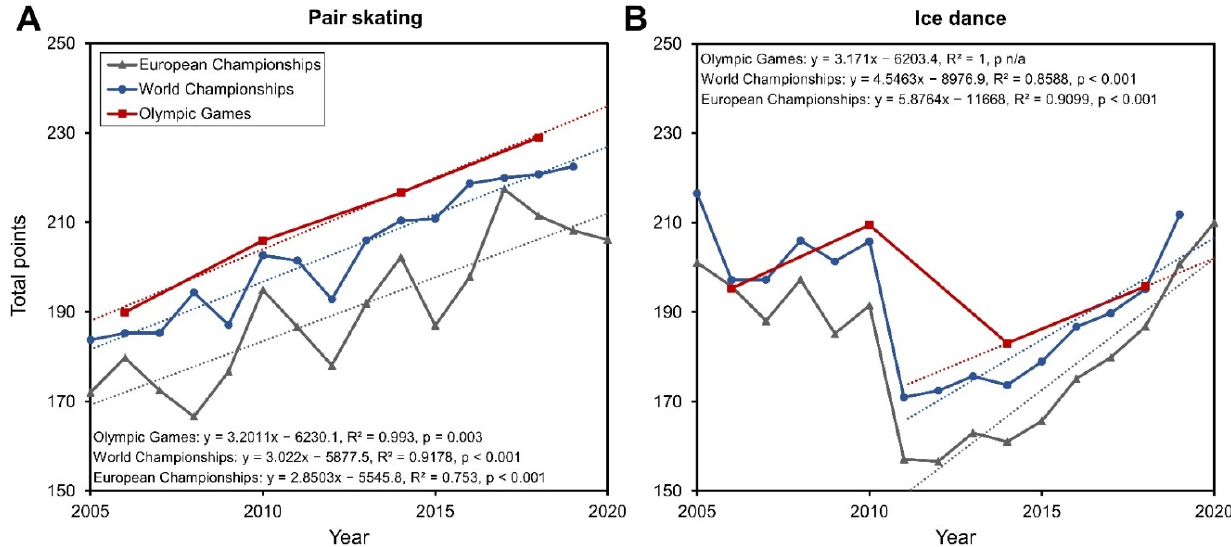
Figure 1. Trends of the average total points of the best five pairs in pair skating ( A ) and ice dance ( B ) at the European and World Figure Skating Championships, and the Olympic Games since 2005. Linear regression analysis was performed to show trends over time in pair skating (2005–2020) and ice dance (2011–2020). Regression functions, coefficients of determination (R 2 ) and p values (ANOVA, dependent variable: average total points of the best five pairs, independent variable: year) are shown for each group. In ice dance, a drop in total points followed a change in regulations in 2010. Note the performance peaks in pair skating at the European Championships in years with Winter Olympics. Table 1. Regression parameters for Figure 2 including slopes in jumps/year, coefficients of determination (R 2 ) and the p values indicating if an increase or decrease was significant (significance highlighted in bold). Data are shown for pair skating. In ice dance, only jumps with a single rotation are allowed.